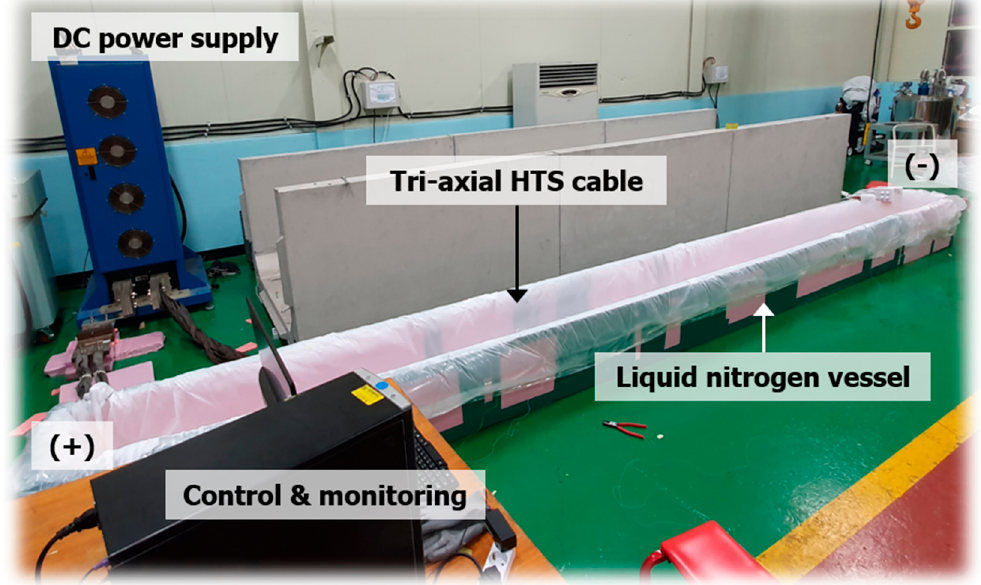
Figure 10. Real configuration of the DC Ic measurement for the 6-m-long tri-axial HTS power cable.